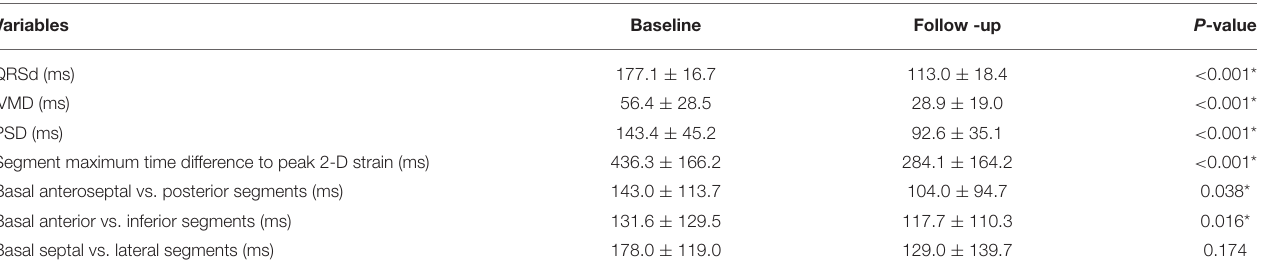
TABLE 3 | Asynchronization status in the LBBAP group at baseline and